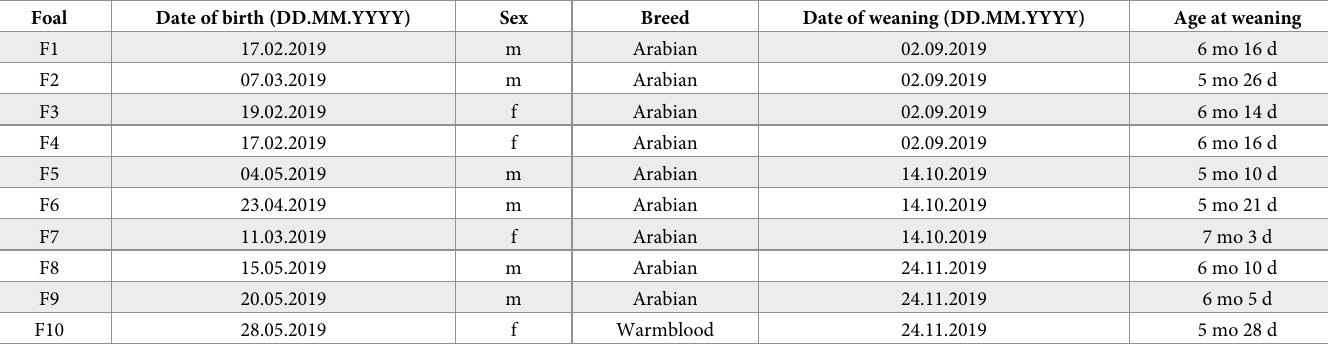
a variable time of the day and the sedation would have falsified the results. For simplification, a timeline was created in which the day before weaning is defined as day 1 and the following days are consecutively numbered (Fig 1). Resulting from that, the first measurement (M1)